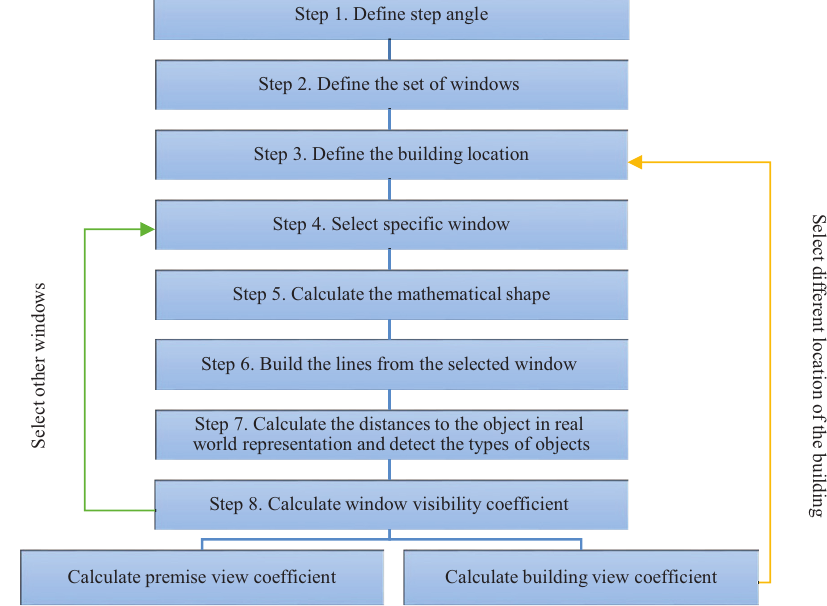
Figure 2. Methodological scheme of the window visibility